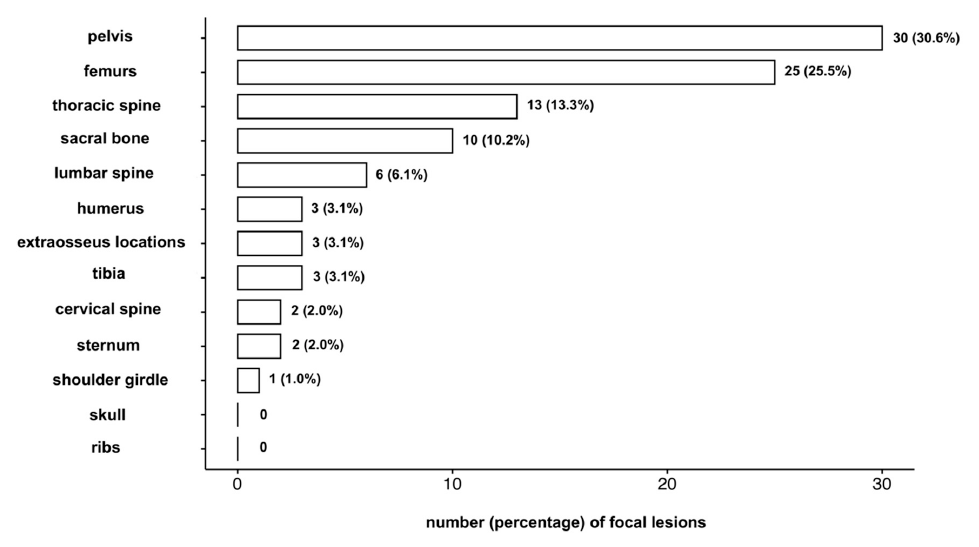
Figure 1. Spatial distribution of focal lesions in smoldering multiple myeloma patients. The number and percentage of focal lesions detected in each anatomical region is given, with overall 98 focal lesions detected in 36 of the 147 patients in the baseline cohort.